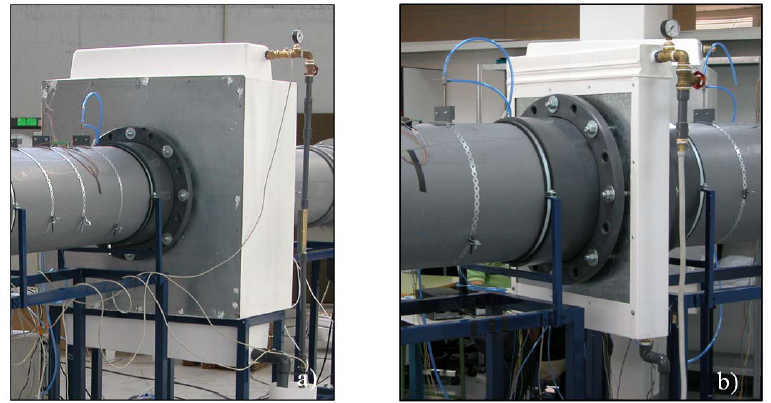
Figure 5. Frame for testing evaporative materials: ( a ) plastic grid block; ( b ) cellulose